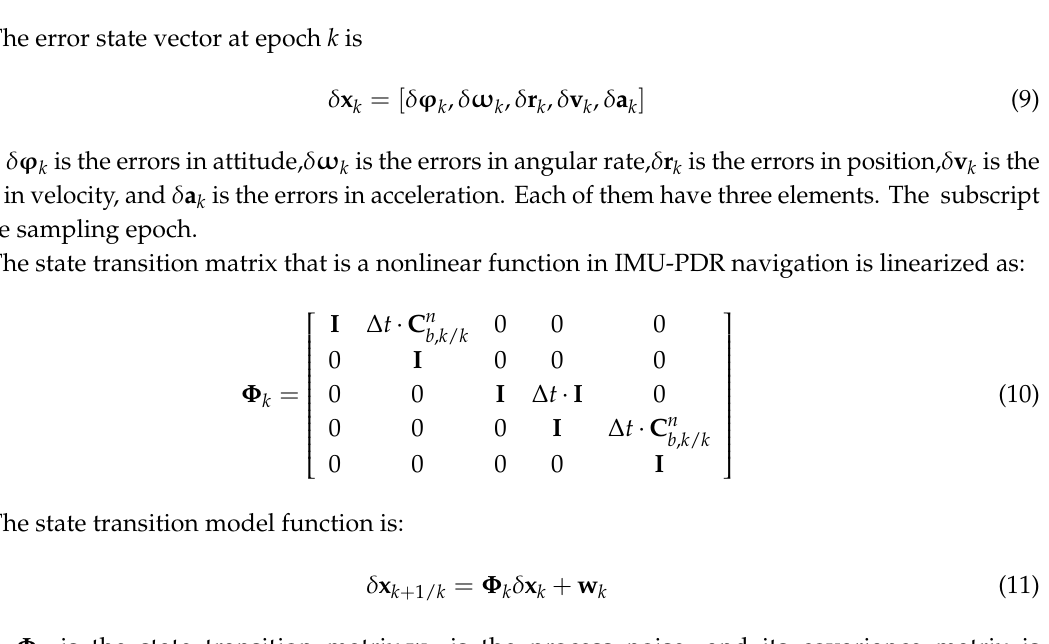
Figure 7. The block diagram of the proposed system.